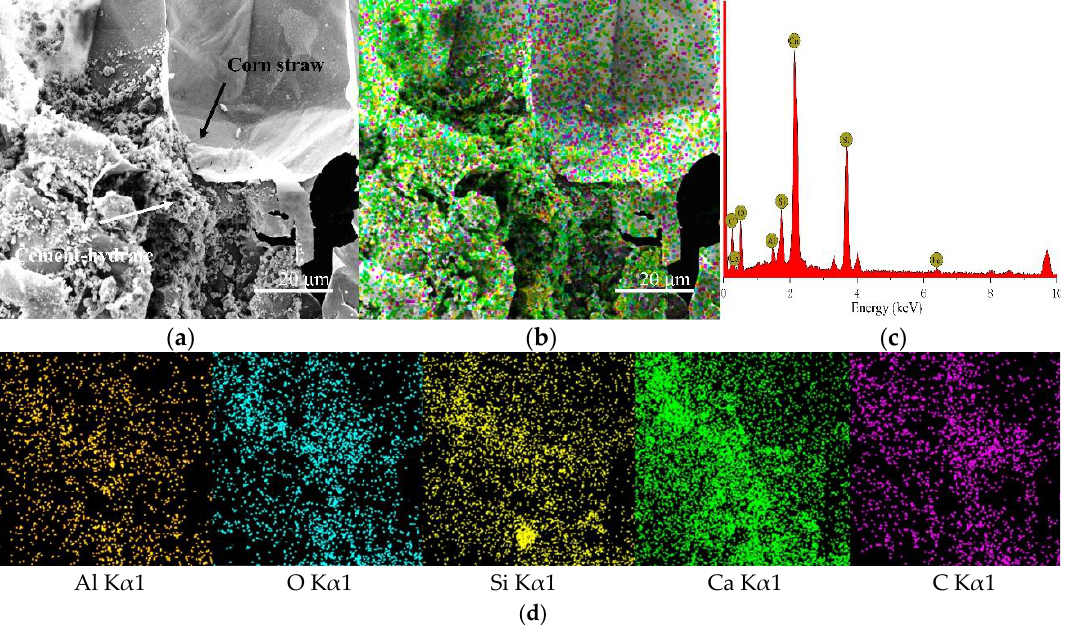
Figure 17. EDS scanning diagram of CSCC-5: ( a ) SEM of CSCC, ( b ) element distribution of CSCC, ( c ) energy spectrum of CSCC, ( d ) single element distribution diagram.